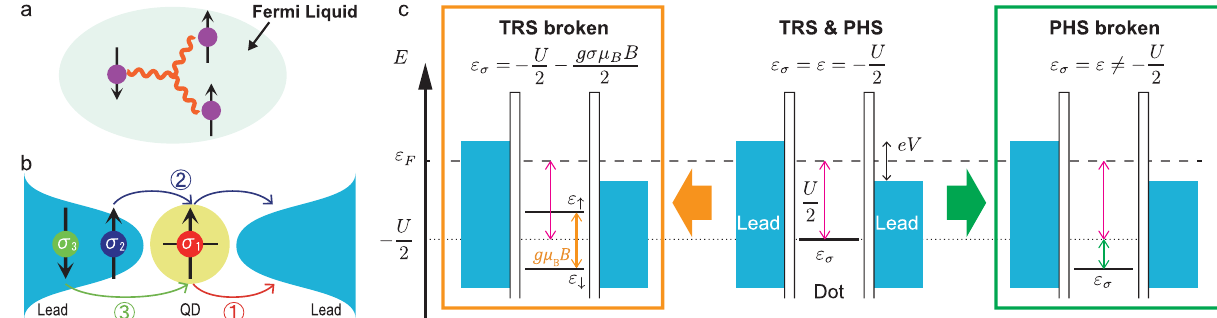
Fig. 1 Three-body correlations and symmetry breaking in a quantum dot in the Kondo regime. a Schematic view of the correlations between the three electrons accounting for the Fermi liquid correction. b Schematic view of the three-body correlation χ ↑↑↓ . Electrons fl uctuate between the quantum dot (QD) and the leads in the equilibrium and all those processes are summed up in χ ↑↑↓ . c (center) QD with the time-reversal symmetry (TRS) and particle- hole symmetry (PHS). The energy level is ε σ = − U /2. The two-body correlations χ σ are fi nite, while the three-body correlations are quenched. (left) QD 1 σ 2 with broken TRS, where the two spins are separated by g μ B B . (right) QD with broken PHS, where the energy level is ε ≠ − U /2. Experimentally, the gate voltage is applied to the QD in order to tune the energy level. In these broken symmetry cases, the three-body correlations χ σ are fi nite, which we 1 σ 2 σ 3 detect in this